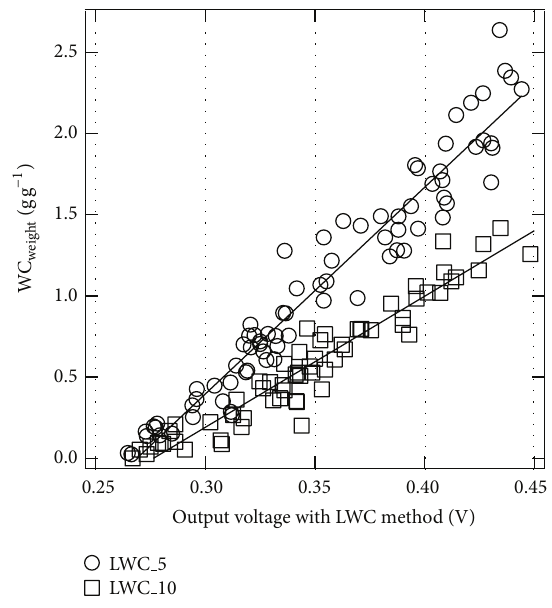
Figure 2: The relationship between the LWC method’s output ) of the leaves voltage and the gravimetric water content (WC weight attached to the sensors. Circles show the data collected with the LWC 5 method ( 𝑛 = 77 , 𝑦 = 12.725 𝑥 − 3.4211, 𝑅 2 = 0.940), where five Quercus serrata leaves were attached to the sensor with rubber bands. Squares show the data collected with the LWC 10 method ( 𝑛 = 66 , 𝑦 = 8.0696 𝑥− 2.2298, 𝑅 2 = 0.942), which used ten Quercus serrata